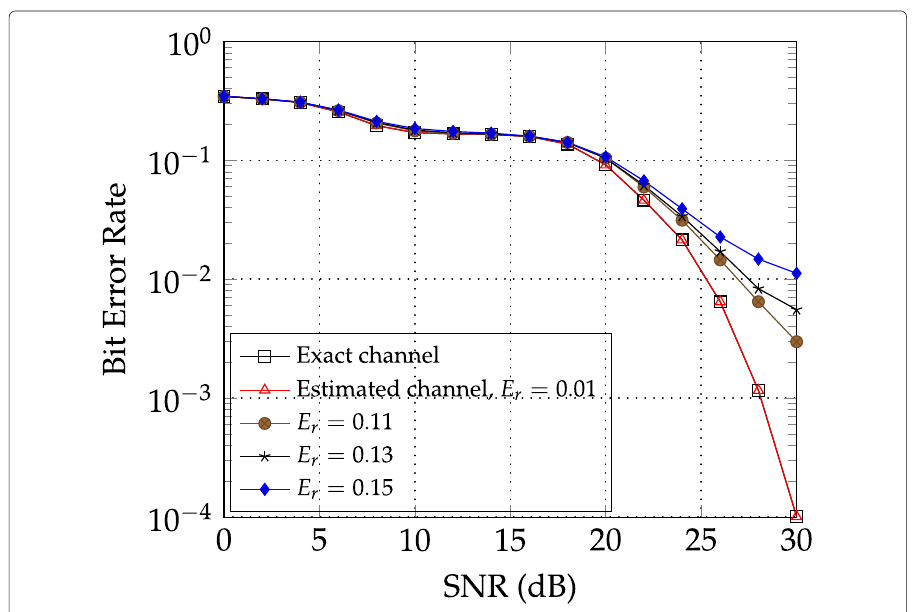
Fig. 12 QR: BER performance with imperfect channel